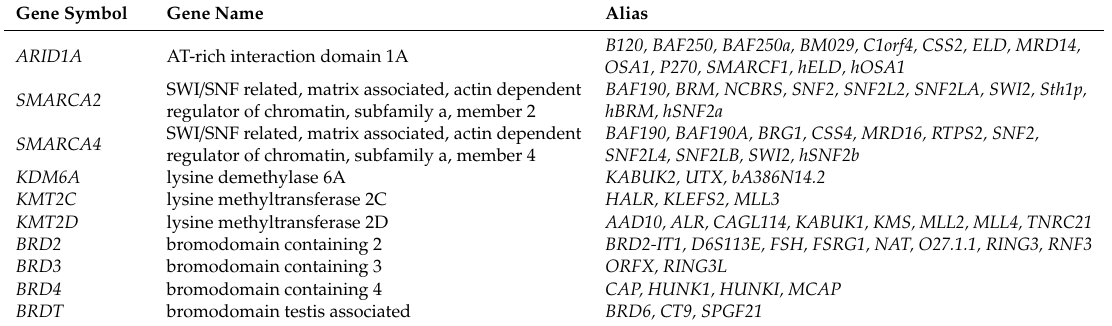
Table 1. Aliases of ARID1A , SMARCA2 , SMARCA4 , KDM6A , KMT2C, KMT2D , BRD2 , BRD3 , BRD4 , BRDT . Gene Symbol